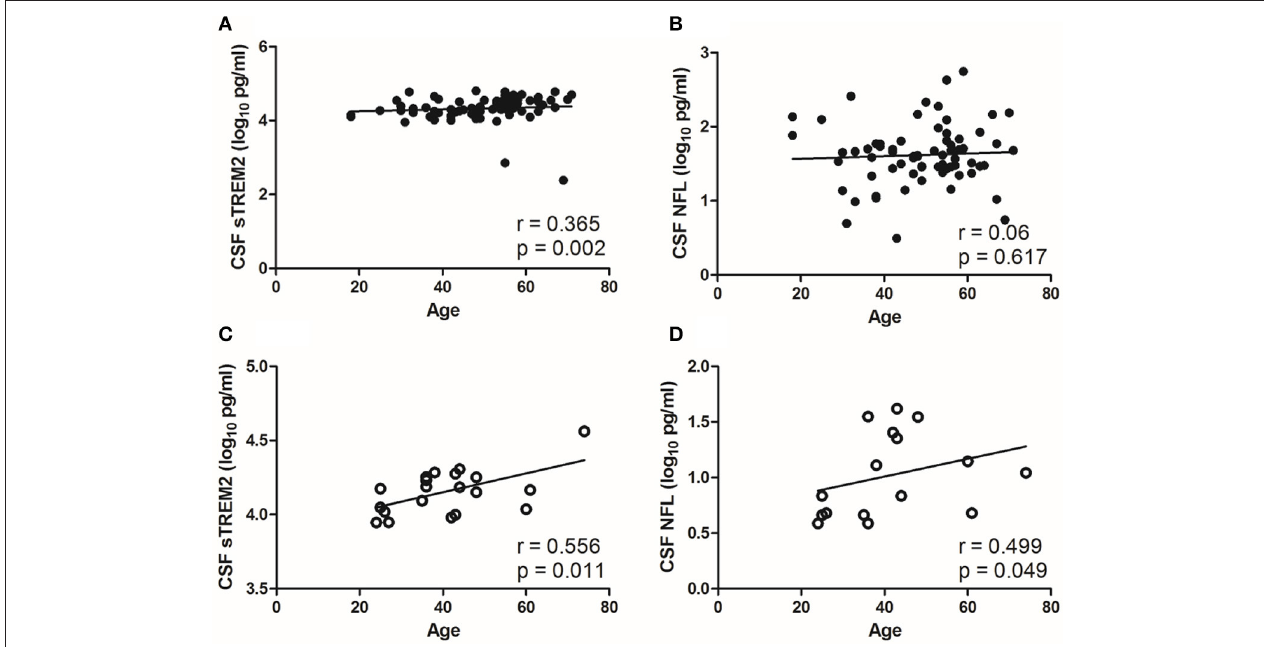
FIGURE 3 | Correlations between CSF biomarkers and age in NS group and syphilis/non-NS group. (A) CSF sTREM2 (log 10 pg/ml) levels were weak correlated with age in NS group. (B) No significant correlation was found between CSF NFL (log 10 pg/ml) and age in NS group. (C) CSF sTREM2 (log 10 pg/ml) levels were moderate correlated with age in syphilis/non-NS group. (D) CSF NFL (log 10 pg/ml) levels were moderate correlated with age in syphilis/non-NS group. NS, neurosyphilis; CSF, cerebrospinal fluid; sTREM2, soluble triggering receptor expressed on myeloid cells 2; NFL, neurofilament light protein.